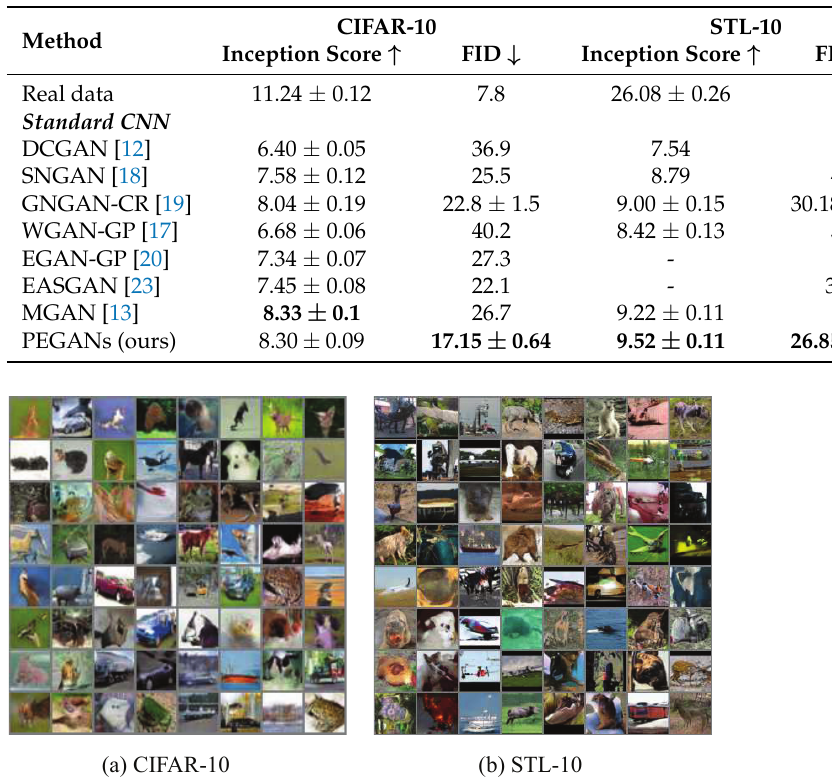
Table 1. Comparison of IS and FID with state-of-the-art methods on CIFAR-10 and STL-10 (unsuper- vised image generation). “-” indicates that no results were reported in the paper.